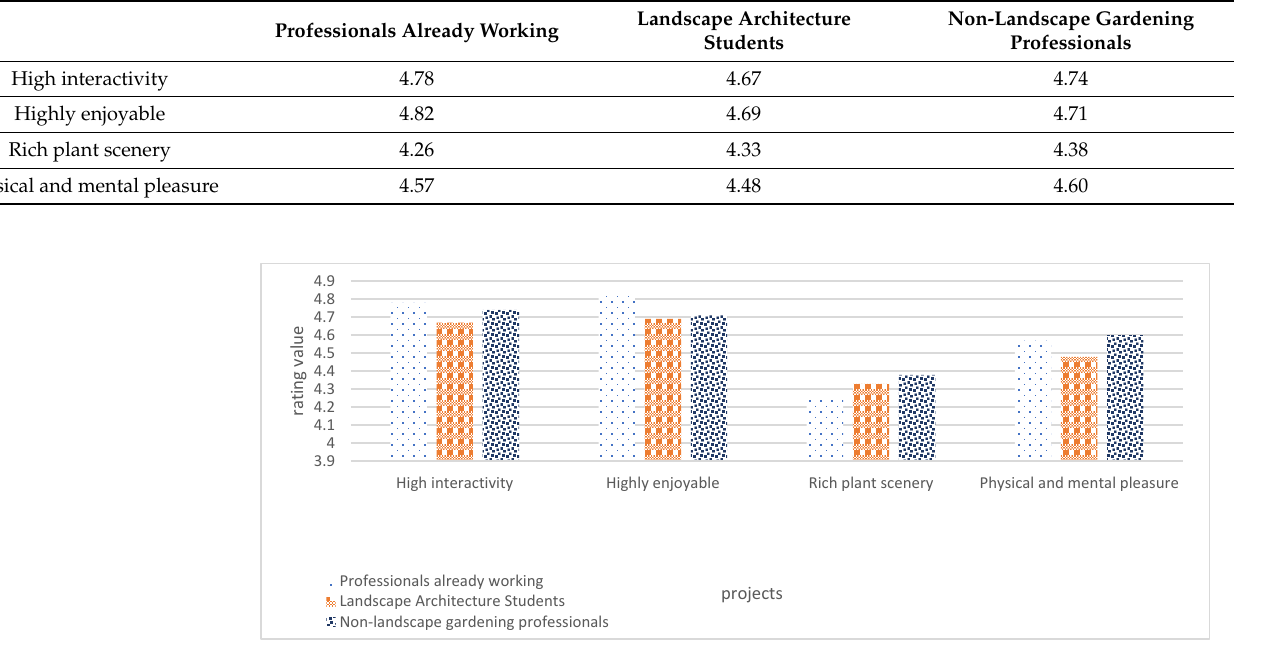
Figure 11. Evaluation of design effects .